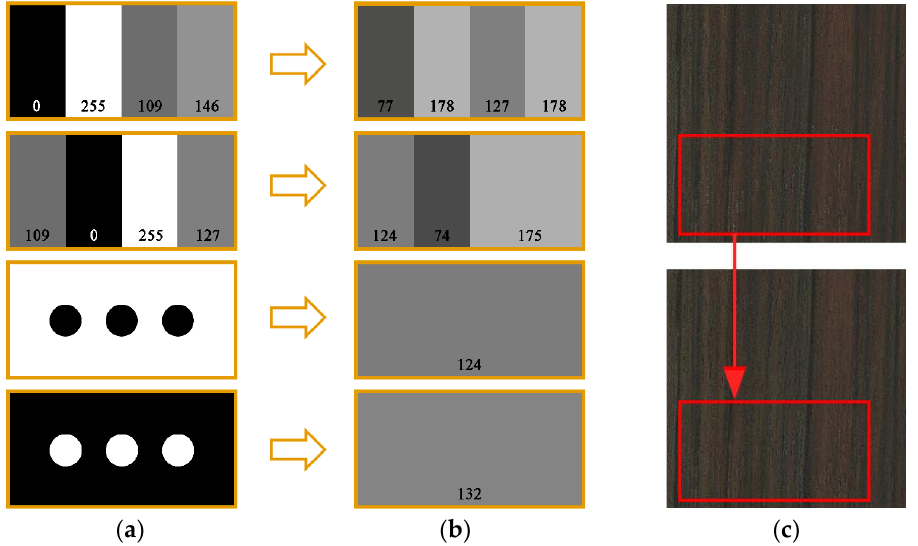
Figure 4. Grayscale images ( a ) before the Gaussian histogram specification; ( b ) after the Gaussian histogram specification. The numbers represent the grayscale values. ( c ) The No.3 images before and after the Gaussian histogram specification.